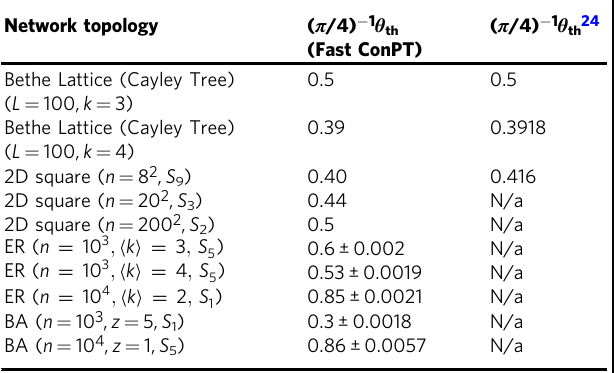
Table 1 Concurrence percolation thresholds of different network topologies. Network